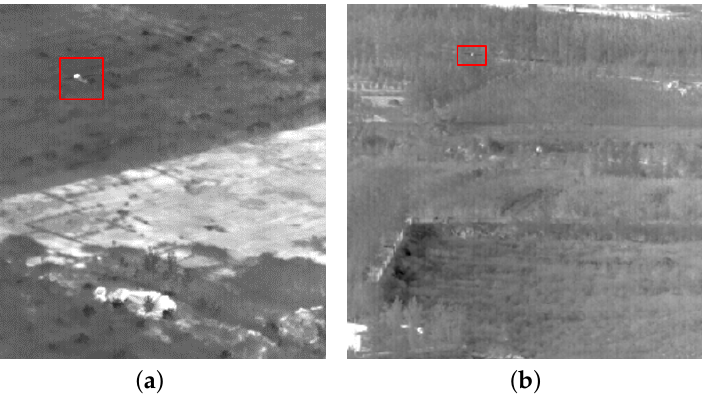
Figure 10. Different imaging sizes of the same target; ( a ) is the image collected when the target distance is close, and ( b ) is the image collected when the target is far